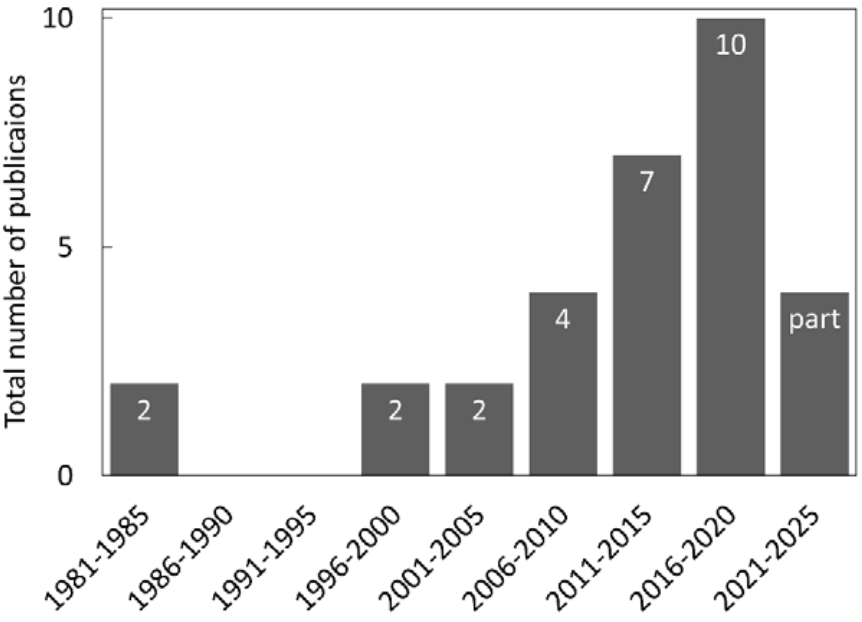
Figure 2. Number of publications on bioerosion research in the South China Sea over time in 5-year brackets, as based on a Google Scholar search using the search term ‘”bioerosion AND “South China Sea”” yielding 31 publications between 1982 and early 2022.